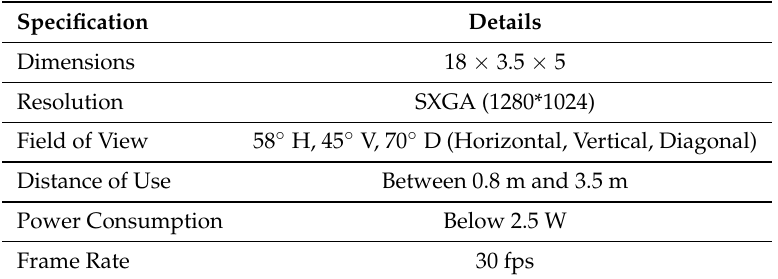
Table 2. RGB-D camera